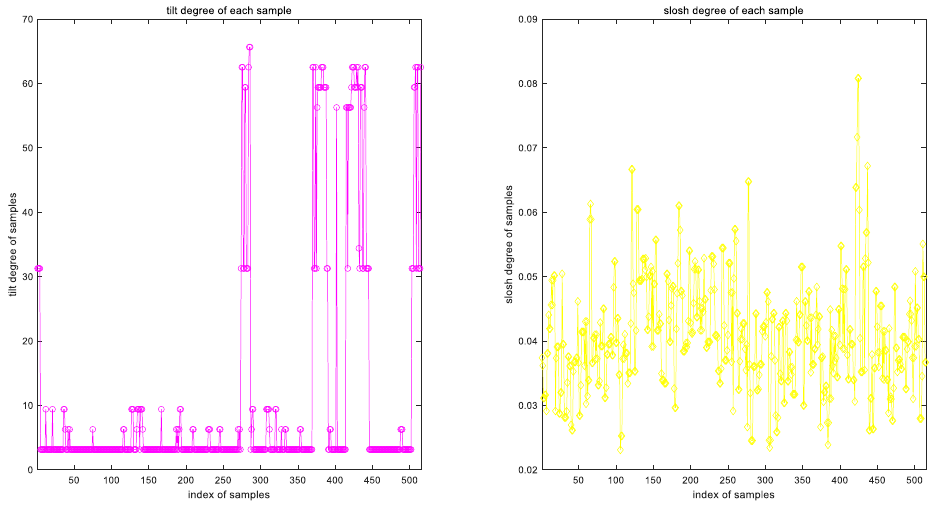
Figure 4. Dataset input attribute-related values.